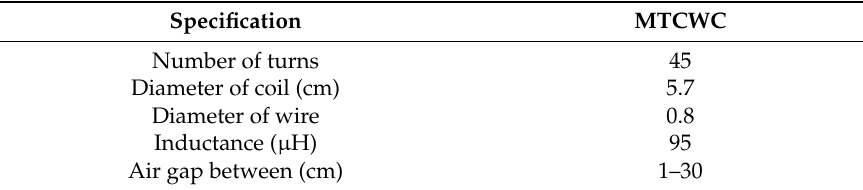
Table 3. Parameters of MTCWC.